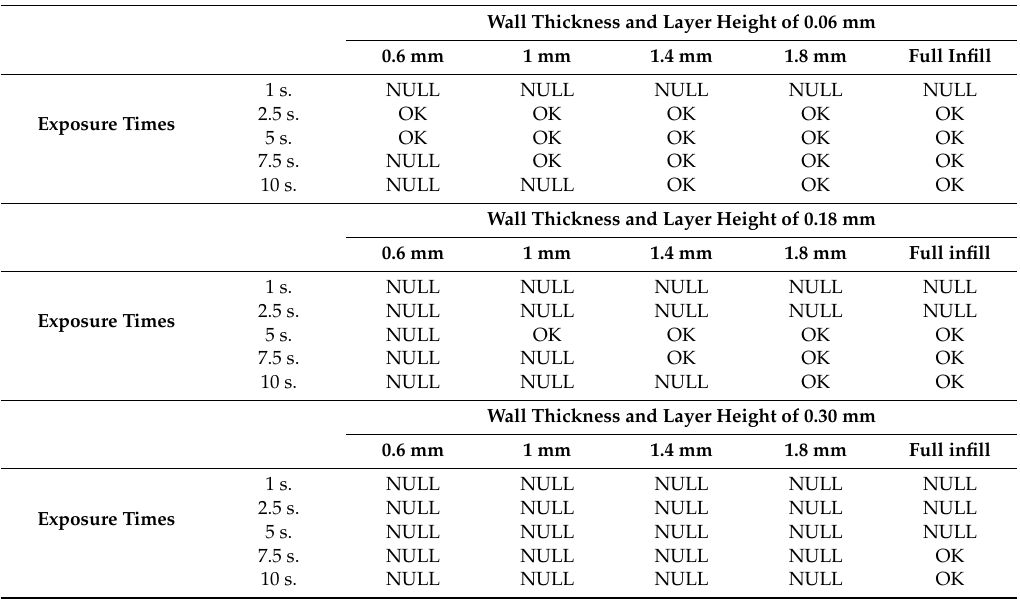
Table 10. Groups of samples with di ff erent printing variables and exposure times suitable for chemical surface